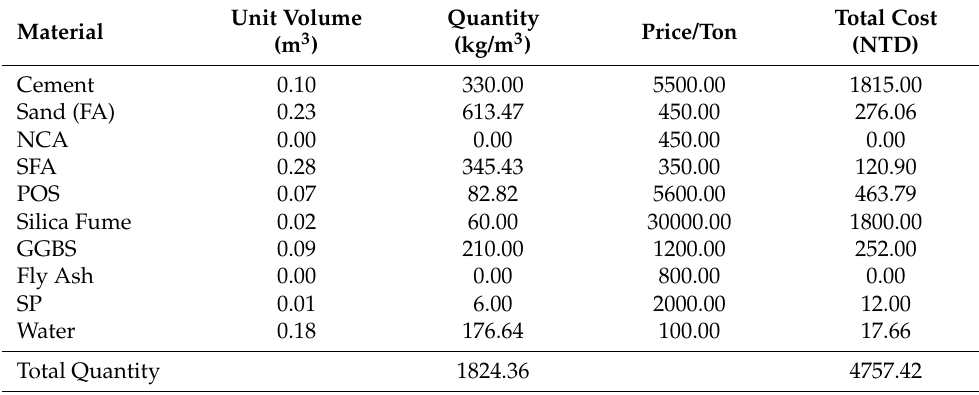
Table 8. E-3 lightweight high strength concrete (80% SFA + 20% POS) in NTD.